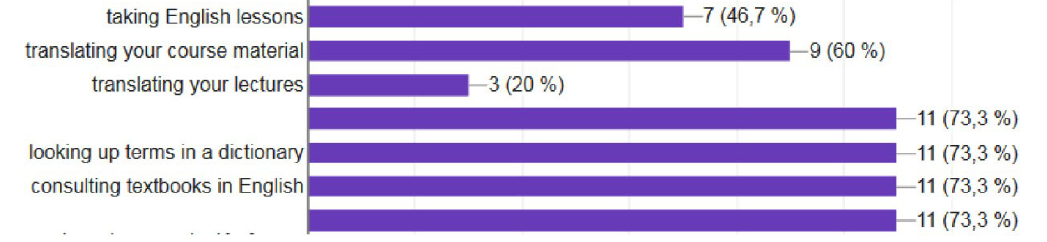
Figure 3. Preparation time